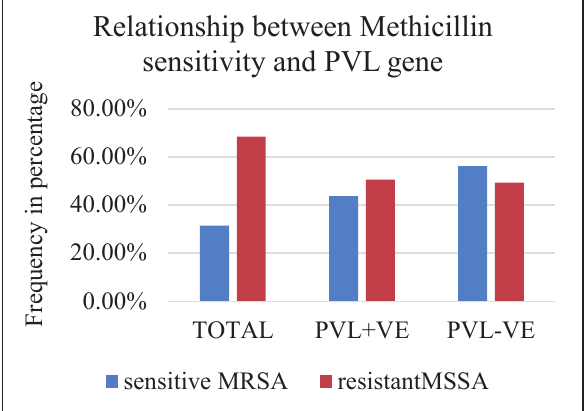
Fig-2: Relation between Methicillin sensitivity and